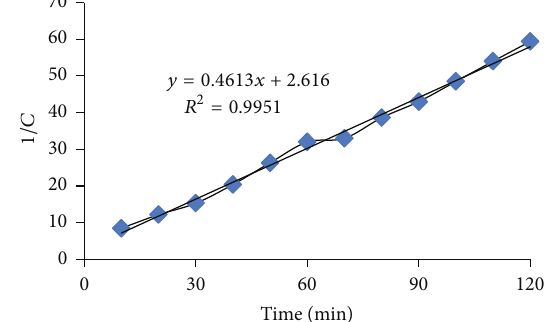
Figure 7: TOC removal for MAG dye by Fenton-like oxidation process.